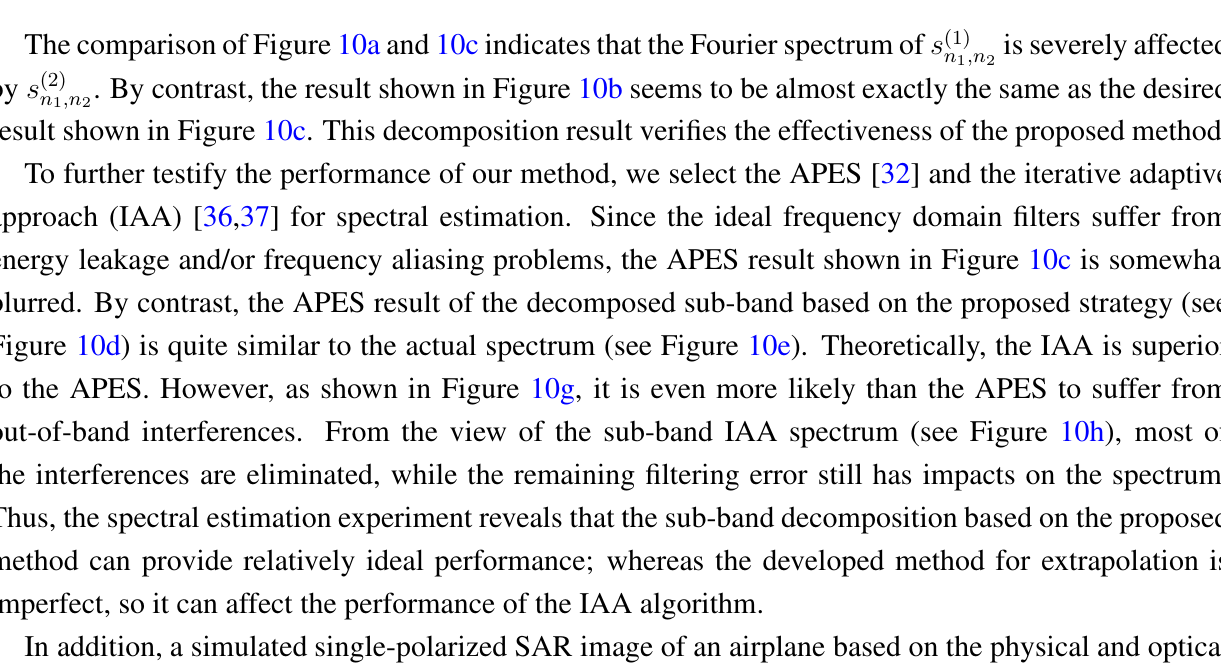
Figure 9. Actual magnitude spectrum of the 2D signal (the black dot corresponds to s p 1 q 0 dB; the rounded blue spot ‚ corresponds to s p 2 q be